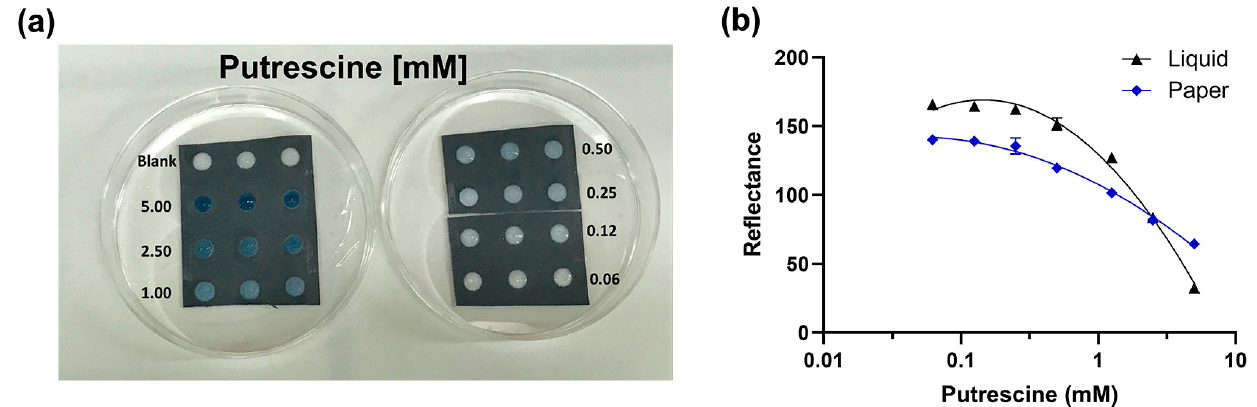
Figure 2. ( a ) Picture of the putrescine calibration curve (concentration range from 0.06 to 5.0 mM) obtained after 3 h of incubation at room temperature in paper format; ( b ) comparison of putrescine calibration curves (concentration range from 0.06 to 5.0 mM) in liquid (black line) and paper (blue line) format after 3 h of incubation at 25 ◦ C. Error bars are present but not visible due to the minimum variation in reflectance signals obtained between replicates.